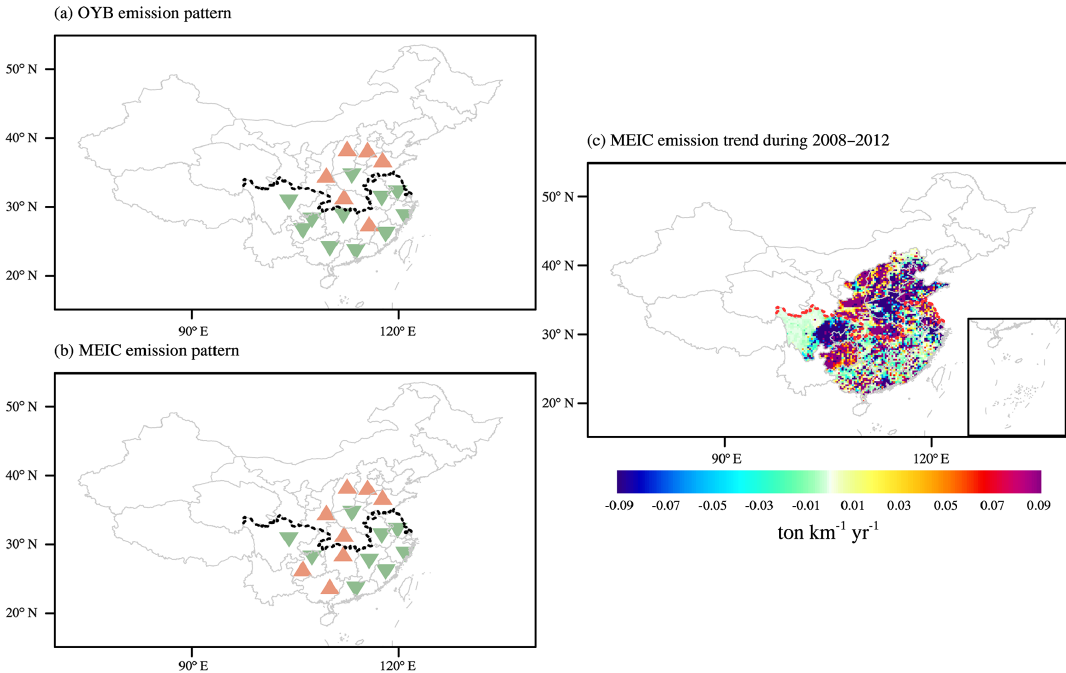
Figure 9. (a, b) Temporal structure classification of SO 2 emission based on OYB and MEIC. Red upward pointing triangles imply non- monotonic decrease with a rebound in the middle, while monotonic decrease is denoted by green downward pointing triangles. (c) Slope of the linear regression of MEIC gridded emission over years 2008, 2010 and 2012. The black or red dotted line delimits North China and South